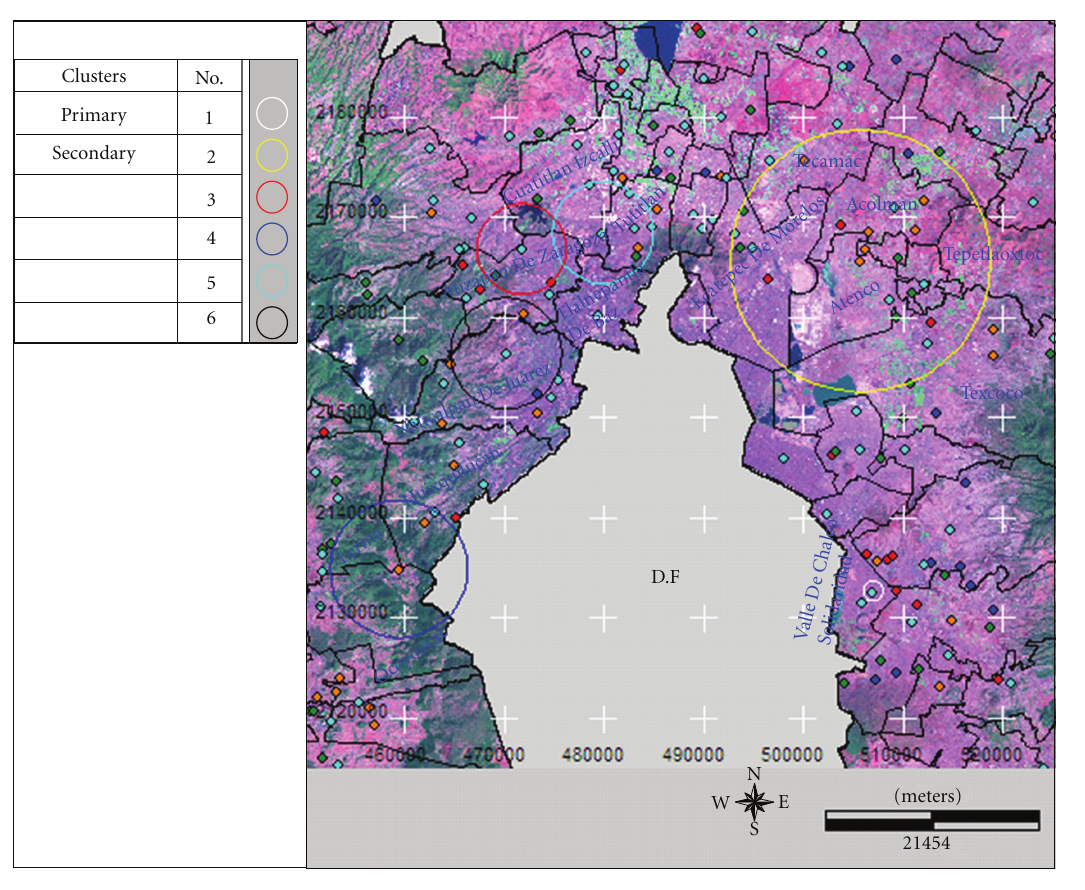
Figure 3: Geography of the identified high TB rate clusters in the State of Mexico detected with a spatial analysis and a search window maximum length of ≤ 50% and ≤ 25% population, adjusted for